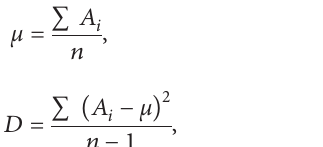
Table 2, the statistical values (means and variances denoted in equations (17) and (18)) also prove that the proposed method has a good stability for indicating the ICF of latent faulty mode.